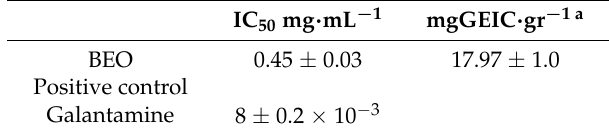
Table 4. Acetylcholinesterase inhibitory properties of Peumus boldus leaf essential